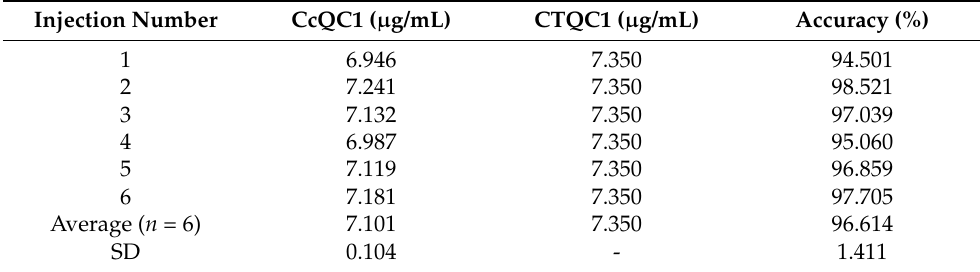
Table 2. Accuracy % calculation after six injections with 7.5 µ g/mL UA QC1 solution.